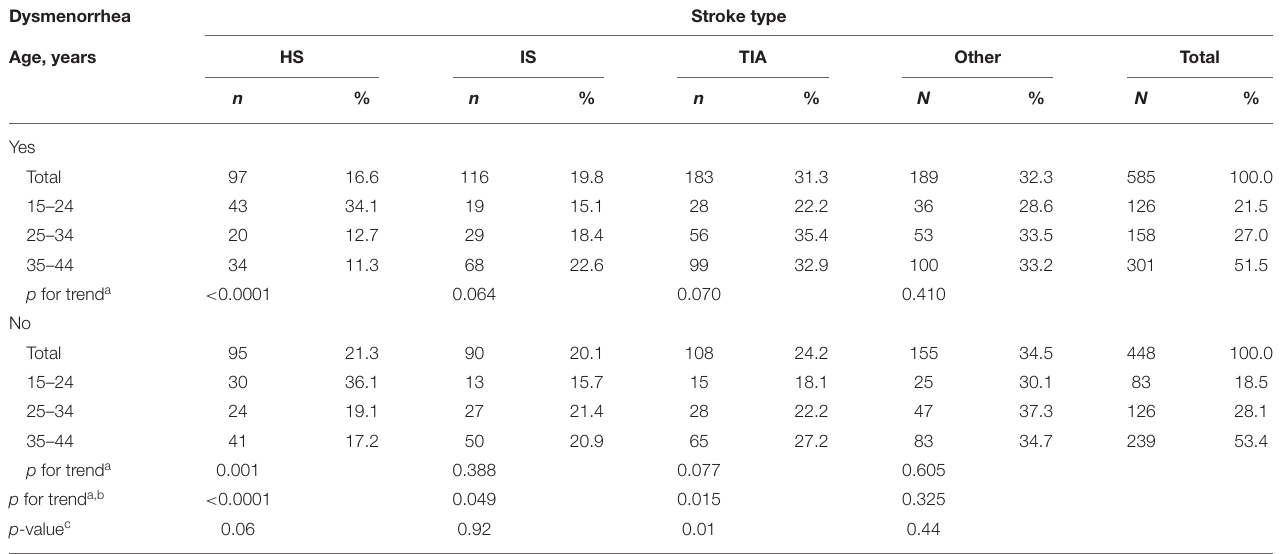
TABLE 2 | Stroke types by age compared between women with and without dysmenorrhea. Dysmenorrhea Stroke type Age,